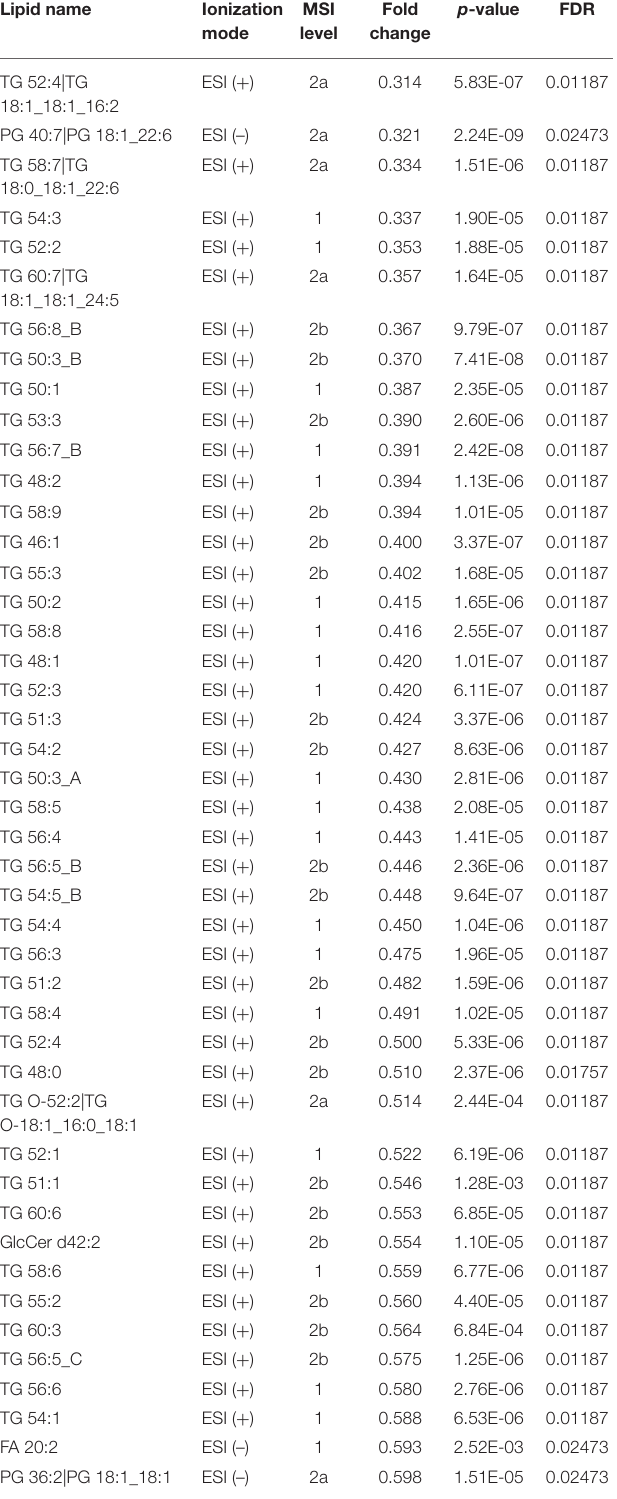
TABLE 2 | Decreased lipids in SH-SY5Y cells after the treatment with olives leaves-sea sand adsorbate (OL-SS) at 40 µ g/mL in comparison to control conditions after